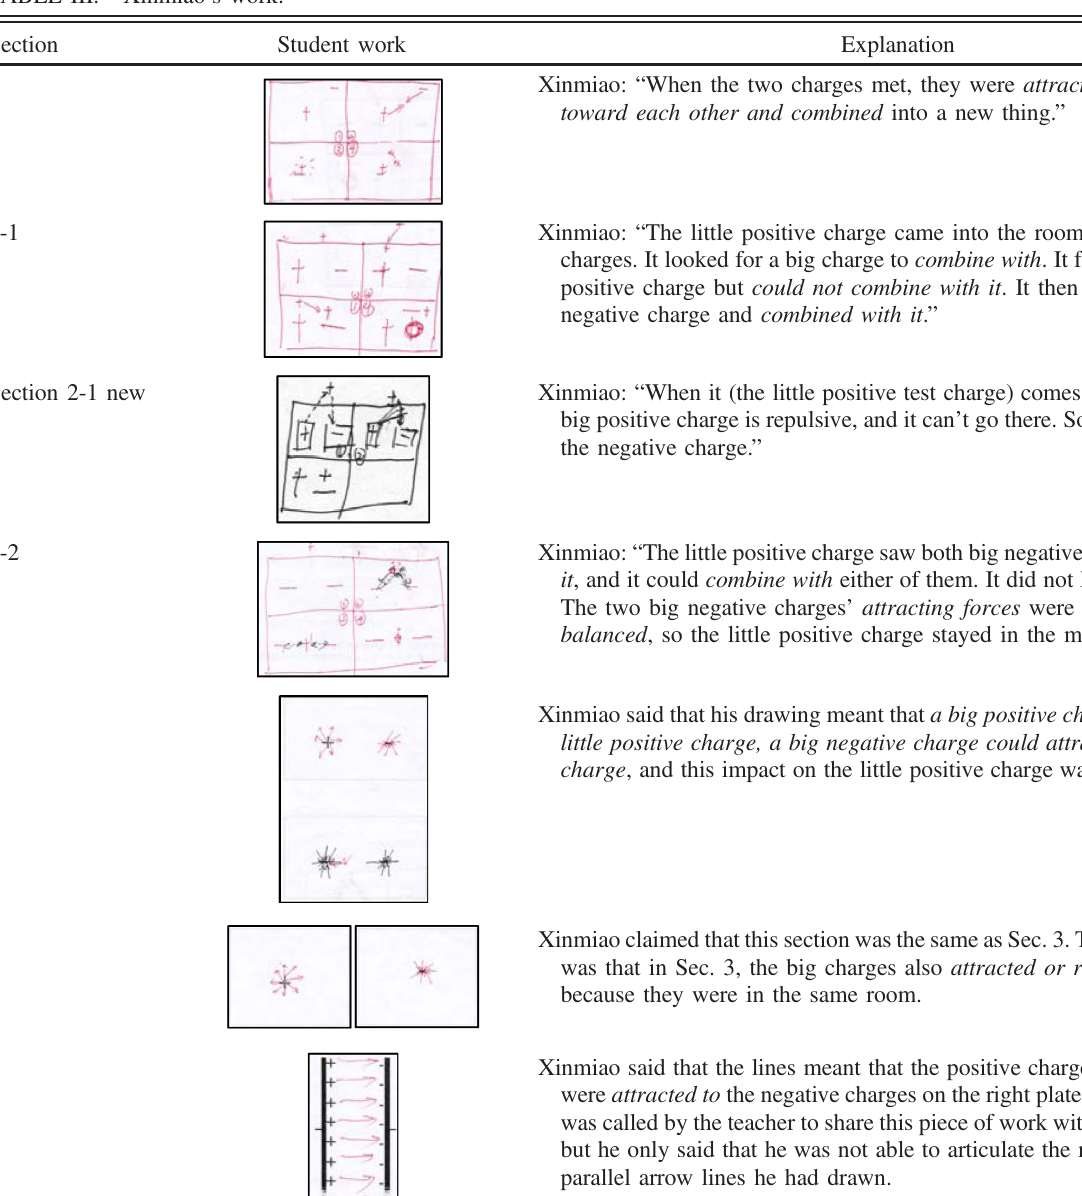
TABLE III. Xinmiao ’ s